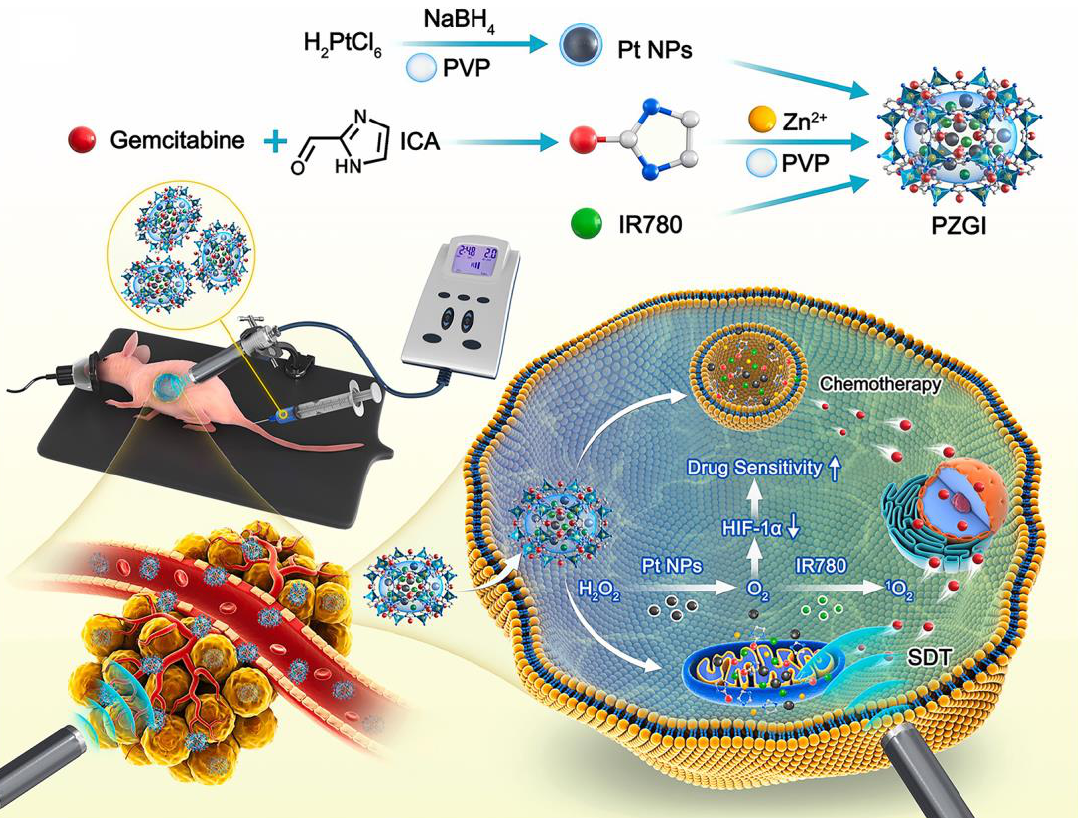
Figure 6. Schematic diagram the pH/ATP dual responsive Pt@ZIF-90@Gem@IR780 for synergistic chemo-sonodynamic therapy of PDAC. Reprinted with permission from [143]. Copyright 2021, Elsevier.